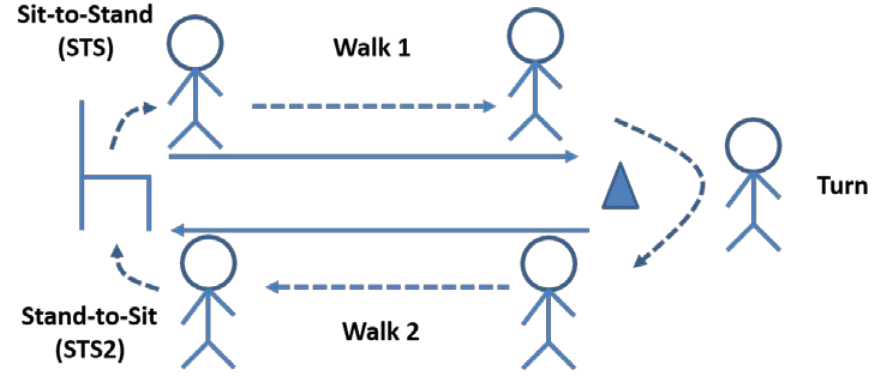
Figure 4. Timed up and go (TUG) test segment diagram.